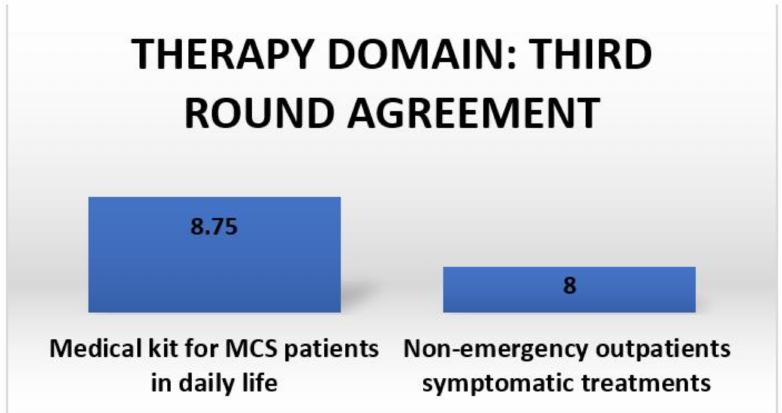
Figure 3. Third round agreement summary for the therapy